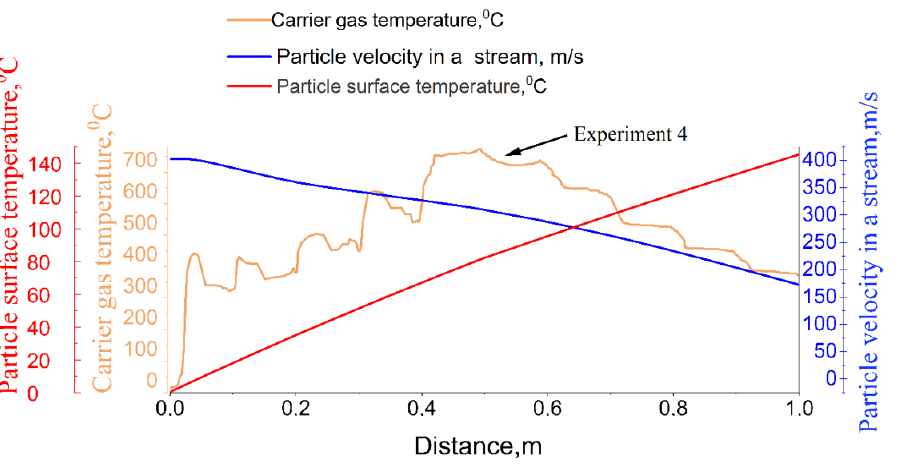
Figure 12. The transported gas’s temperature, the particle’s velocity in the gas flow, and the particle’s surface temperature. Summary